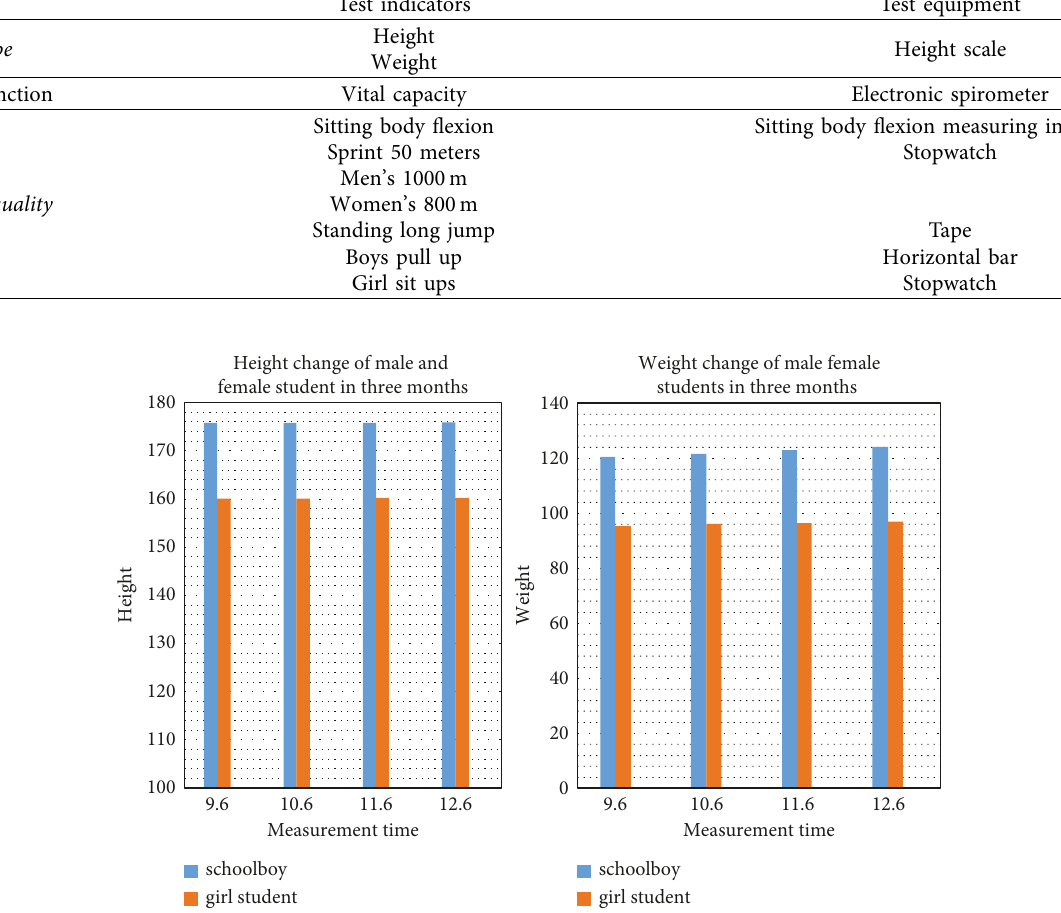
Figure 4: Height and weight of male and female students in group A.